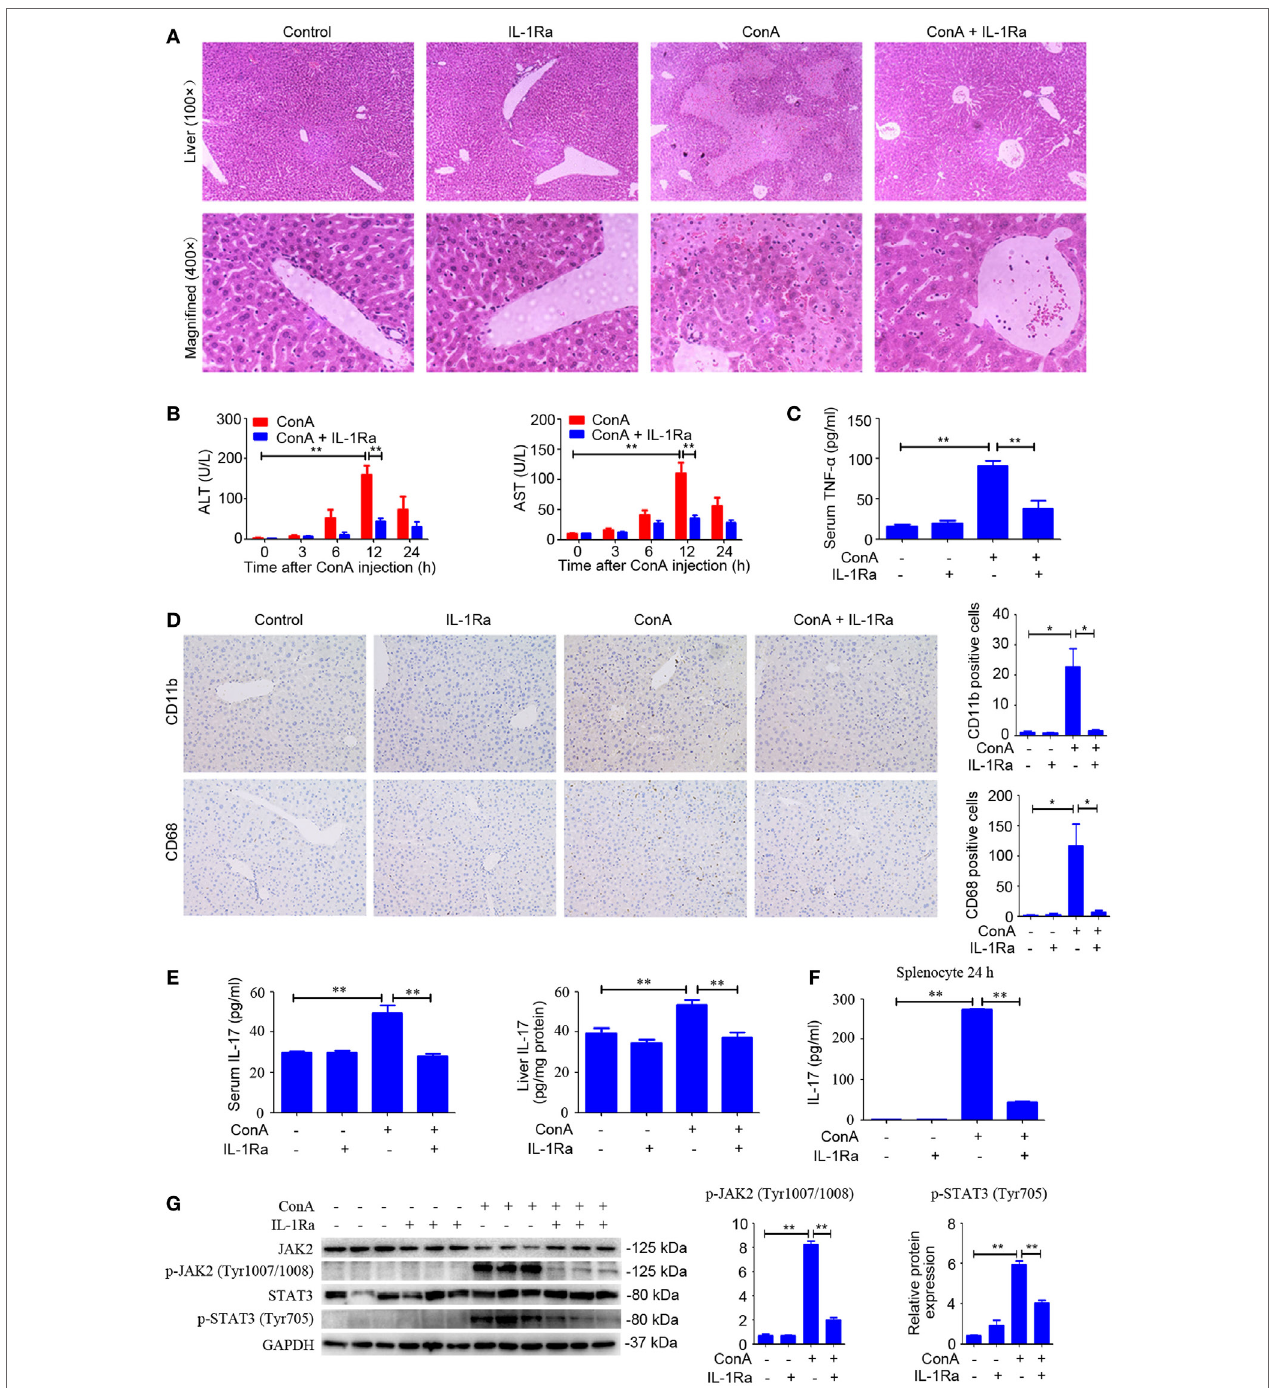
FigUre 4 | Blocking IL-1 β protected ConA-treated mice from acute hepatitis. (a) BALB/c mice ( n = 6 for each group) were pretreated with recombinant human interleukin-1 receptor antagonist (rhIL-1Ra) and subsequently exposed to ConA challenge for 12 h, then sacrificed for collecting samples. Representative H&E images of liver tissues were shown (100 × , magnification: 400 × ). (B) Serum ALT and aspartate transaminase (AST) activity were assessed. (c) Serum TNF- α was analyzed by enzyme-linked immune sorbent assay (ELISA). (D) Representative immunohistochemical images of CD68 or CD11b staining in the liver tissue of mice. Quantification of the number of CD11b-positive cells and CD68-positive cells were obtained in four visual fields ( × 100) in each group. (e) Level of IL-17 in the serum and livers were assessed by ELISA. (F) Primary splenocytes were treated with 10 µg/ml rhIL-1Ra in the presence of 1 µg/ml ConA. The concentration of IL-17 in the supernatants was measured by ELISA. (g) Western blot was performed to detect JAK2, p-JAK2 (Tyr1007/1008), STAT3, and p-STAT3 (Tyr705) in the livers. Each lane represented a separate animal. The blots were representative of three experiments. Quantification of protein expression with Image J software. The data were presented as means ± SD (Student’s t -test, * p < 0.05, ** p < 0.01).